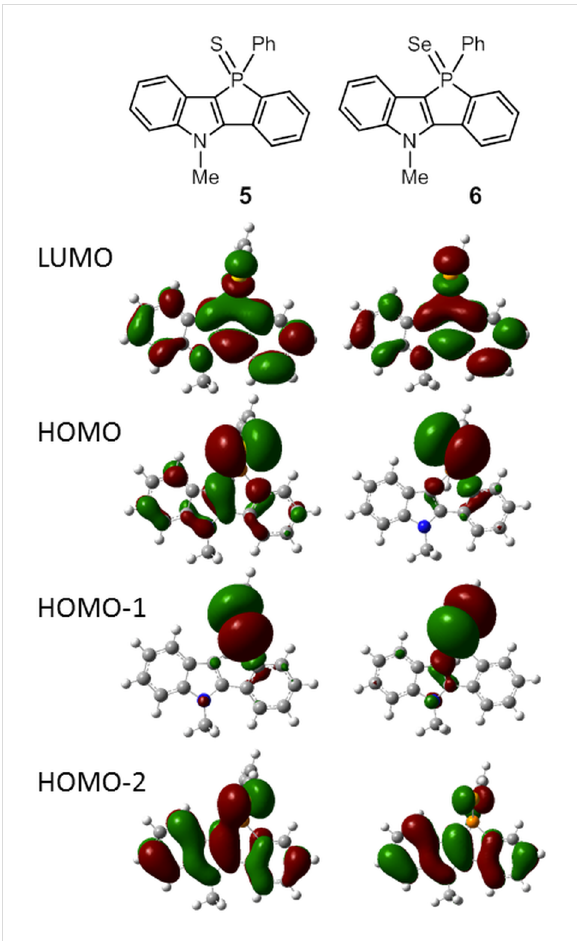
Figure 5: The spatial plots of the selected molecular orbitals of com- pounds 5 and 6 . The calculations were performed at the level of